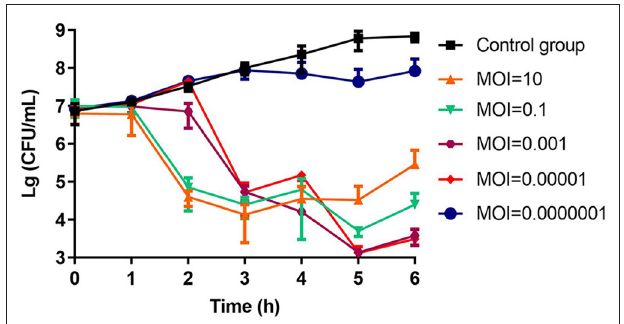
FIGURE 4 | The bactericidal activity of phage vB_CbrM_HP1 in vitro. Phage vB_CbrM_HP1 and isolate Cbr-1 were cocultured in LB broth at different MOIs (10, 0.1, 0.001, 0.00001, and 0.0000001). No phage vB_CbrM_HP1 was added to the control group. The changes in the bacterial population in each group over 6h were measured. The means and standard deviations are represented as points with error bars ( n = 3).